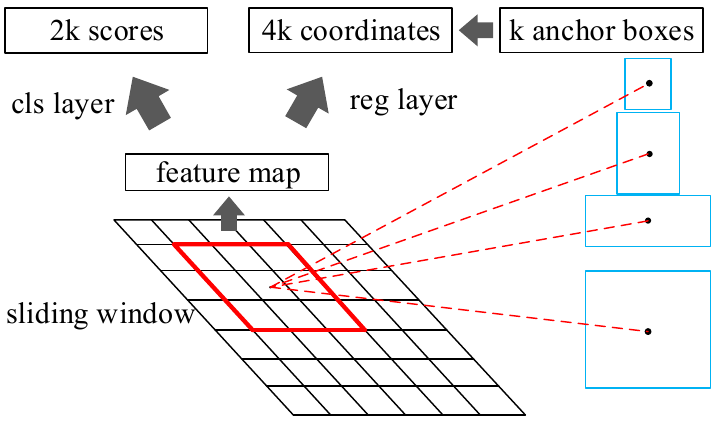
Figure 3. The region proposal network (RPN) structure.